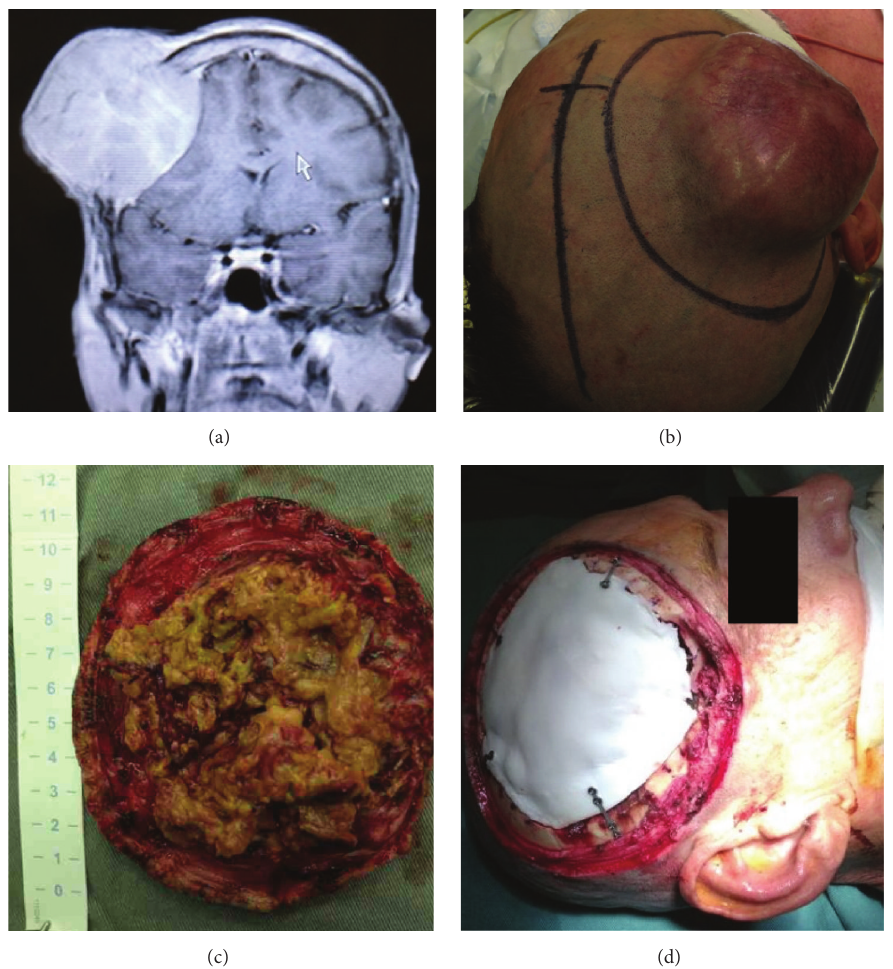
Figure 1: Intraoperative photos showing. (a) Brain MRI sequence with GD in T1 showing lesion with homogeneous enhancement contrast in scalp associated with bone invasion and compressive effect on the adjacent brain parenchyma. The mass enhanced homogeneously. (b) Delimitation of skin incision around the tumor on the right, midline delimitation on the left. (c) Tumor measures after the tumor resection. (d) Cranioplasty with bone